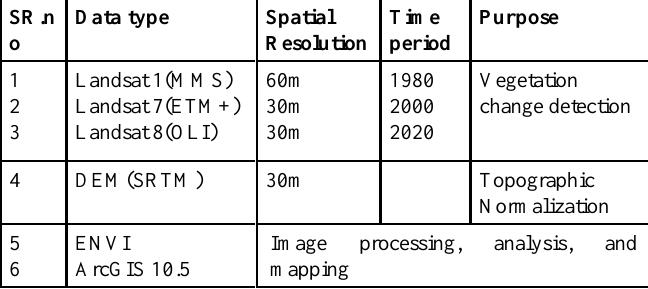
Table 1: Datasets and Processing Tools